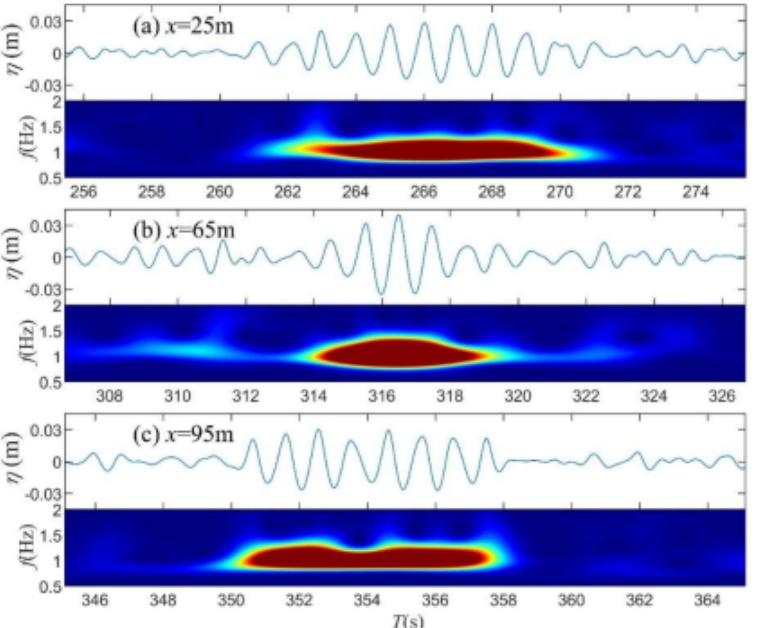
Figure 14. The time series and corresponding wavelet spectrum for Soliton 3 at three locations: ( a ) x = 25.0 m; ( b ) x = 65.0 m; ( c ) x = 95.0